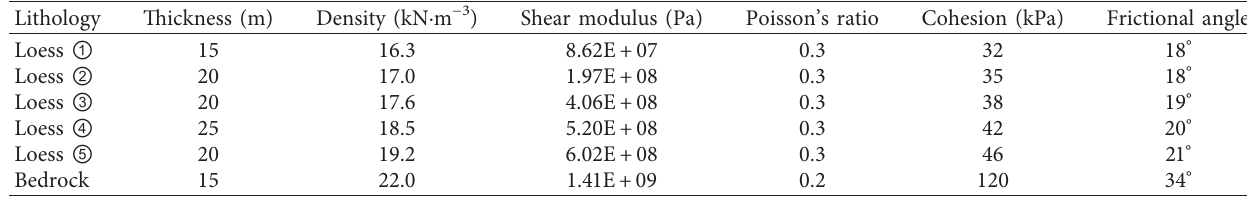
Figure 9: Models of finite element analysis. (a) Profile of the loess slope (unit: m) and (b) finite element model. Table 3: Soil mechanics parameters of the finite element